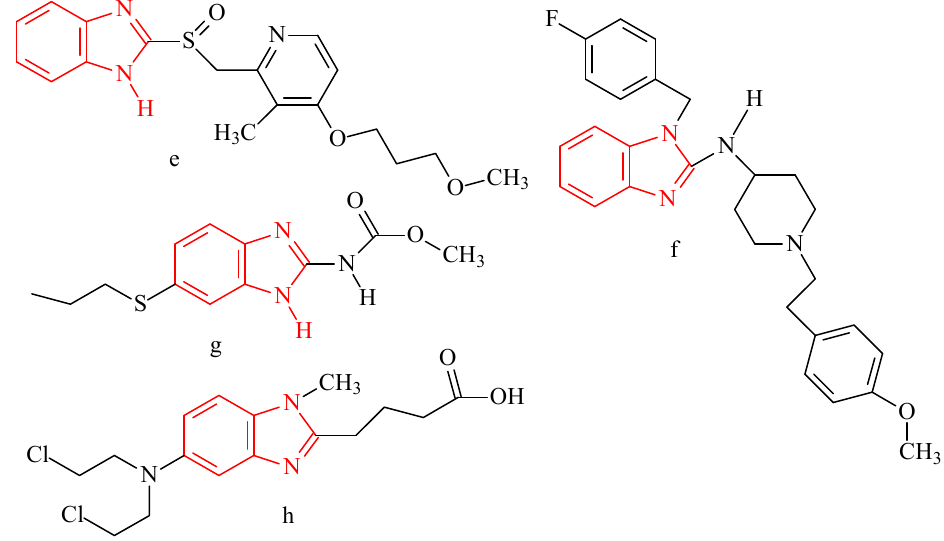
Figure 2. Drugs containing benzimidazole ring.